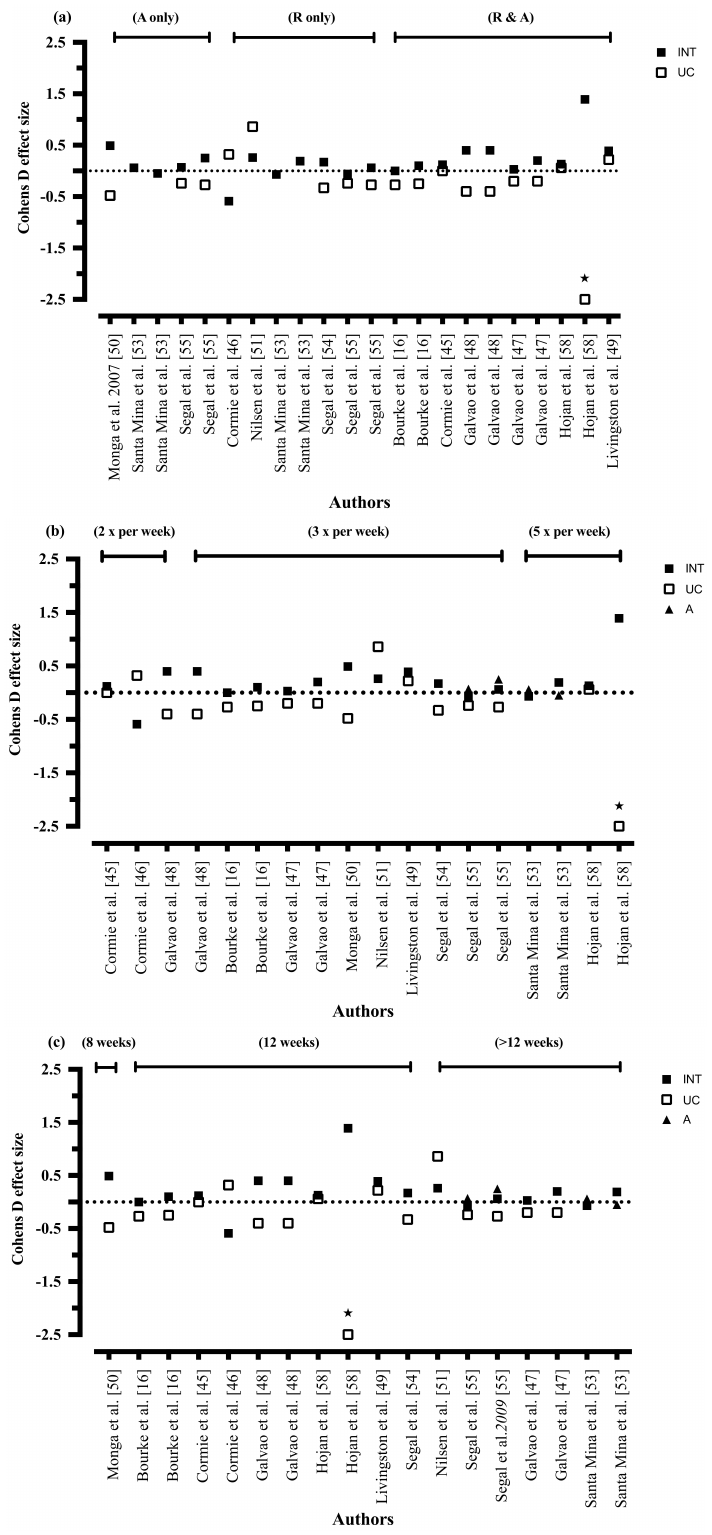
Figure 3. ( a ) Cohens D effect size of exercise mode on quality of life; ( b ) Cohens D effect size of exercise frequency on quality of life; ( c ) Cohens D effect size of exercise duration on quality of life (A = aerobic exercise, R = resistance training, INT = intervention, UC = usual care, b = second measure of quality of life, * = effect size of −